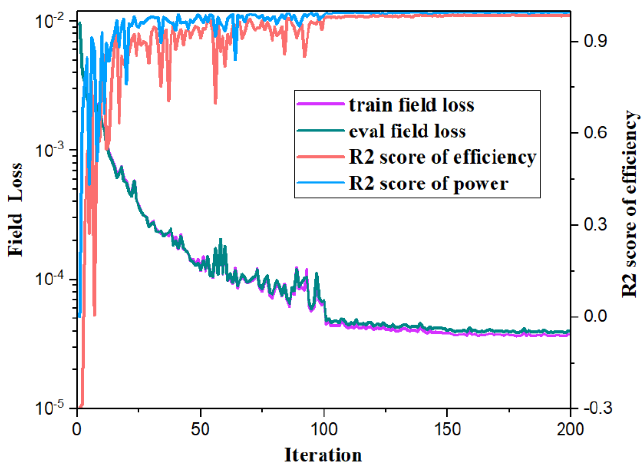
Figure 8. The training process.